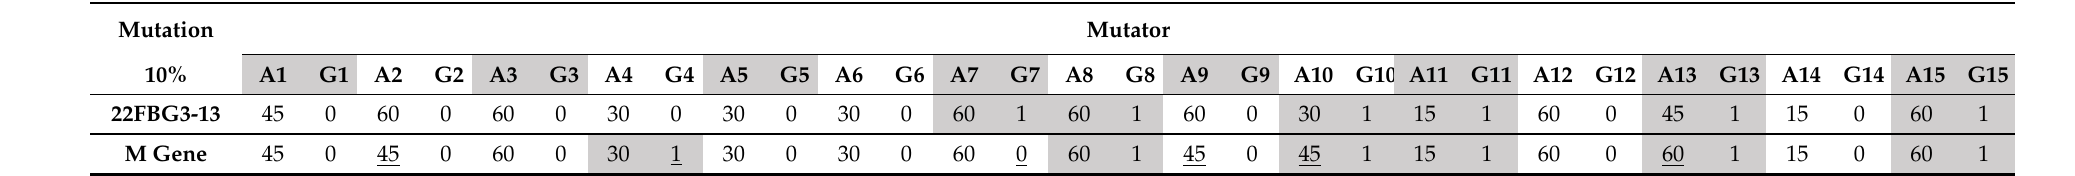
Table 3. Gene mutation